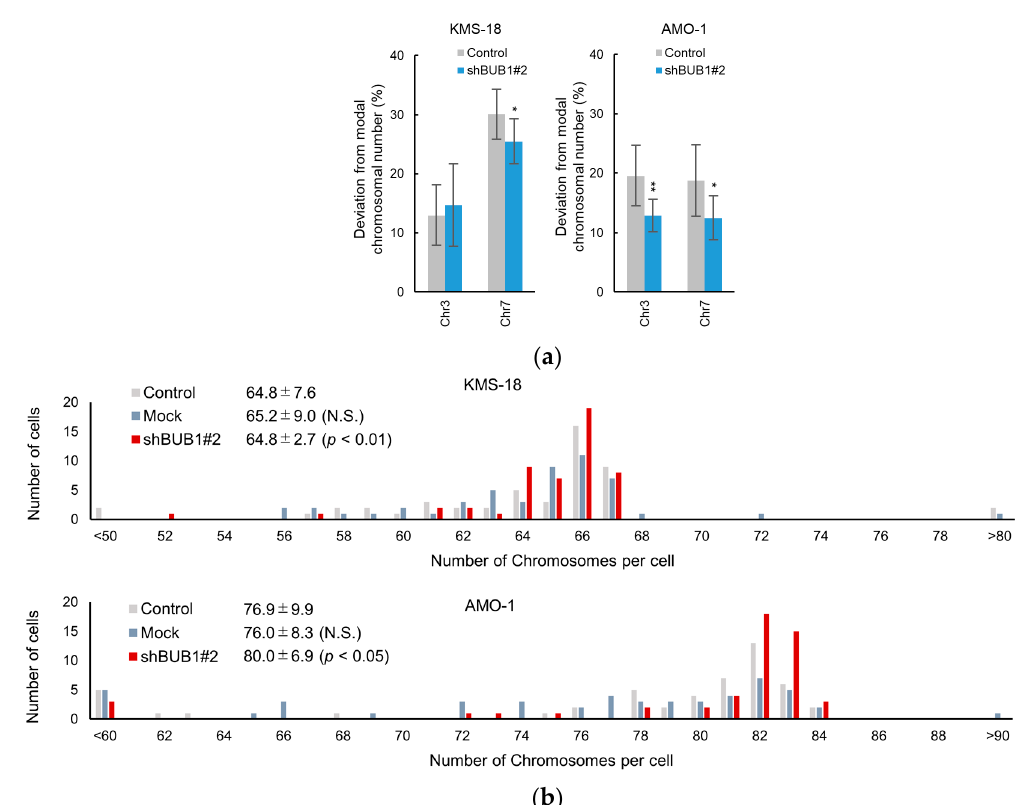
Figure 5. Involvement of BUB1 in the emergence of aneuploidy in myeloma cells. ( a ) Percentage deviations from the modal chromosome number for chromosome (chr) 3 and chr 7 in 10 clones of KMS-18 and AMO-1 cells. A total of 100 interphase cells were evaluated for the numbers of the chr 3 and chr 7 in each clone. Gray and white bars represent parental and BUB1-knockdown cells, respectively. Means ± SD of ten independent clones are shown. * p < 0.05, ** p < 0.01 by two-tailed t -test. ( b ) Distribution of whole chromosome numbers of 50 metaphase cells of control (gray), mock-transduced (blue), and BUB1-reduced (red) KMS-18 (upper) and AMO-1 (lower) cells. Numbers are the average chromosome number, SD, and p values vs. control cells in an F test.